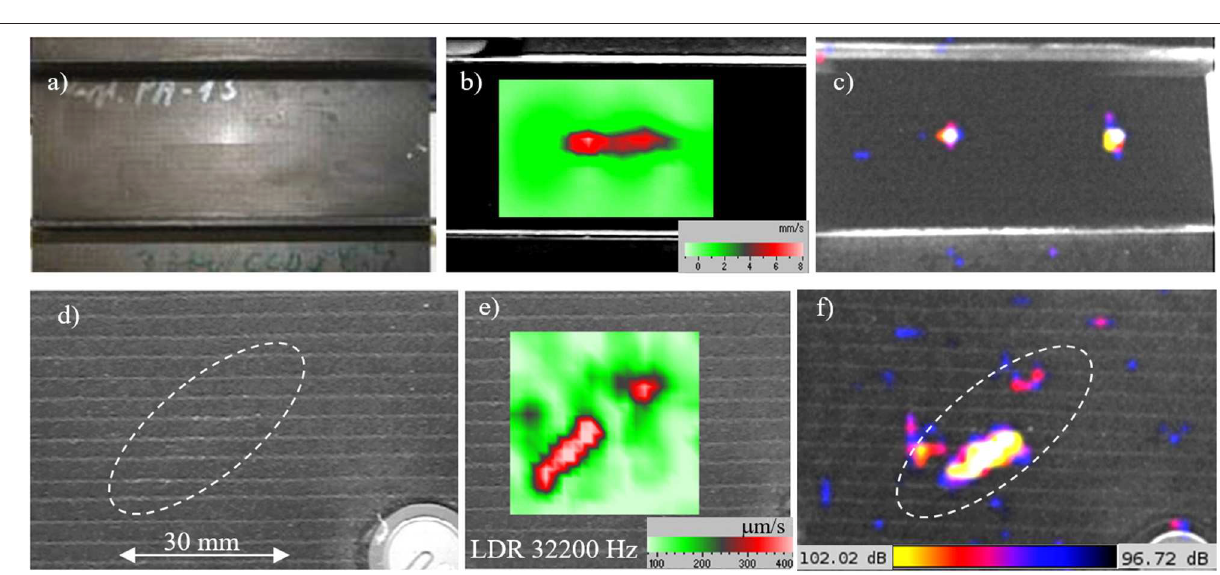
and imaging of the defects in complicated shape